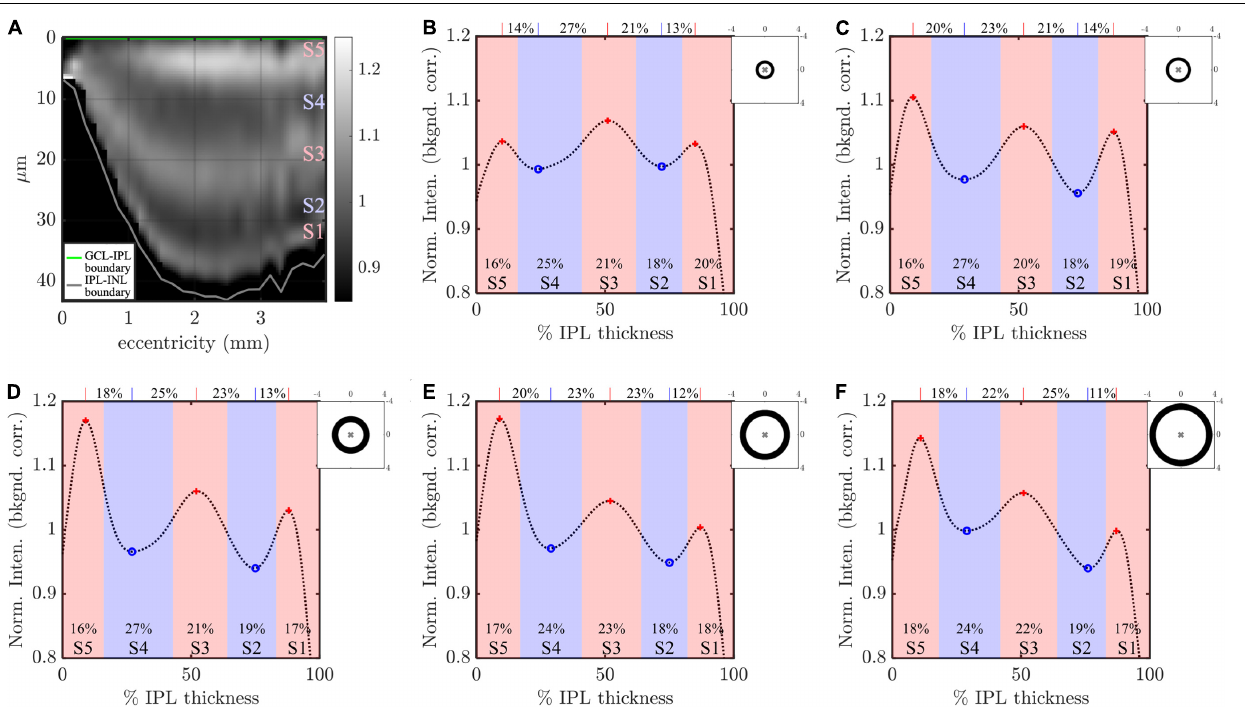
FIGURE 5 | Eccentricity-wise averaging of segmental IPL profiles. (A) Subject-averaged IPL lamination image, obtained by partitioning IPL segments into 25 eccentricity bins, averaging IPL profiles and thicknesses within each bin, then for each eccentricity bin, rescaling the abscissa of the average segmental profile to the average IPL thickness. IPL profiles, averaged across wider eccentricity bins ( B: 0.75–1.13 mm, C: 1.13–1.5 mm, D: 1.5–2.25 mm, E: 2.25–3 mm, F: 3–3.75 mm). Both the image (A) and the plotted profiles (B–F) suggest an increase in the prominence of S5 starting near the foveal edge (0.75 mm). Note that while averaging across subjects and within eccentricity bins yields smooth profiles, individual profiles may not align; therefore, stratum contrast is reduced in this figure relative to Figures 6A , 7A . Topographic images in (B–F) show annuli for eccentricity binning relative to the foveal center